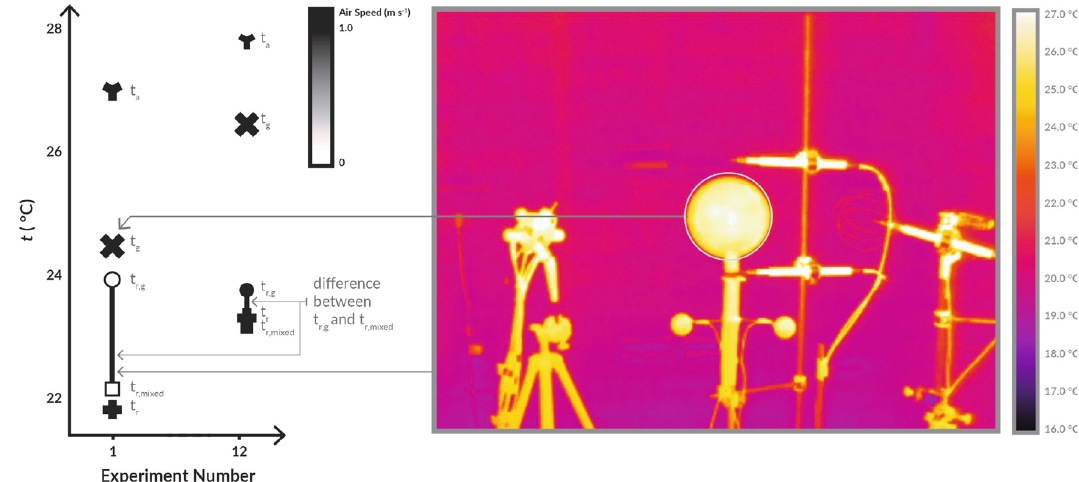
Figure 3. Explanation for how to interpret all data presented in Fig. 4 (left) and thermal image of experimental setup (right). The directly recorded physical measurements of air temperature ( t a as Y ), globe temperature ( t g as X ), and radiant temperature ( t r as + ). The calculated radiant temperatures determined from the globe are represented by the circle (current ISO7726 convection correction) and the square (proposed mixed convection correction). The difference between either t r calculated with the standard correction ( t r , g ) or with our proposed correction factor ( t r , mixed ) and the baseline measurement t r represents the impact of convection on the globe compared to a calibrated pyrgeometer measuring only the radiant heat transfer. The line represents the difference between the two corrections. The color (grayscale) fill of the shapes corresponds to the air speed during the measurement used for the forced and mixed convection correction